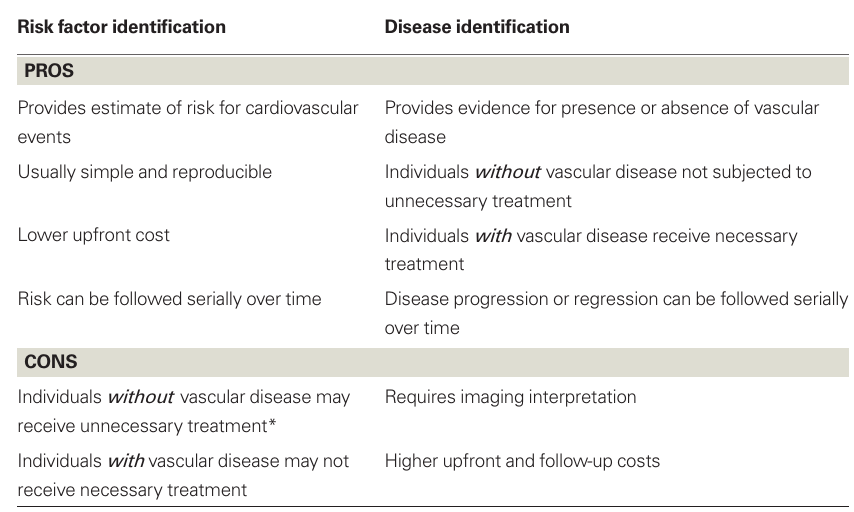
Table 1 | Risk factors for modeling versus disease identification